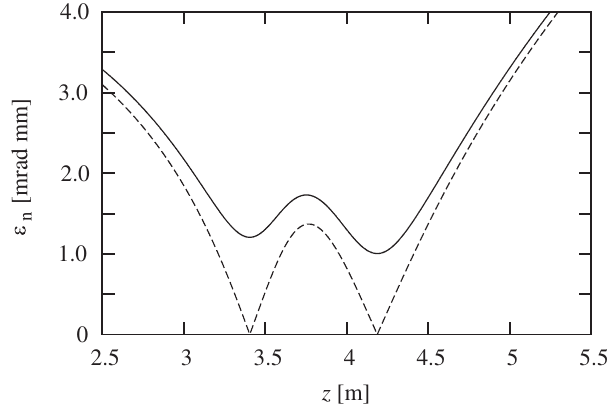
FIG. 9. Development of the beam emittance as calculated from the high perveance and low perveance slices. The broken line ignores the slice emittance; i.e., the slices are treated as lines in phase space. The emittance minima coincide with the locations of equal slopes as shown in Fig.